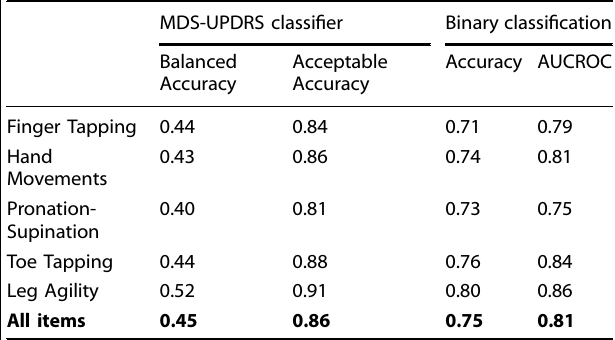
Table 4. Performance of the classi fi cation models, broken down by each item.